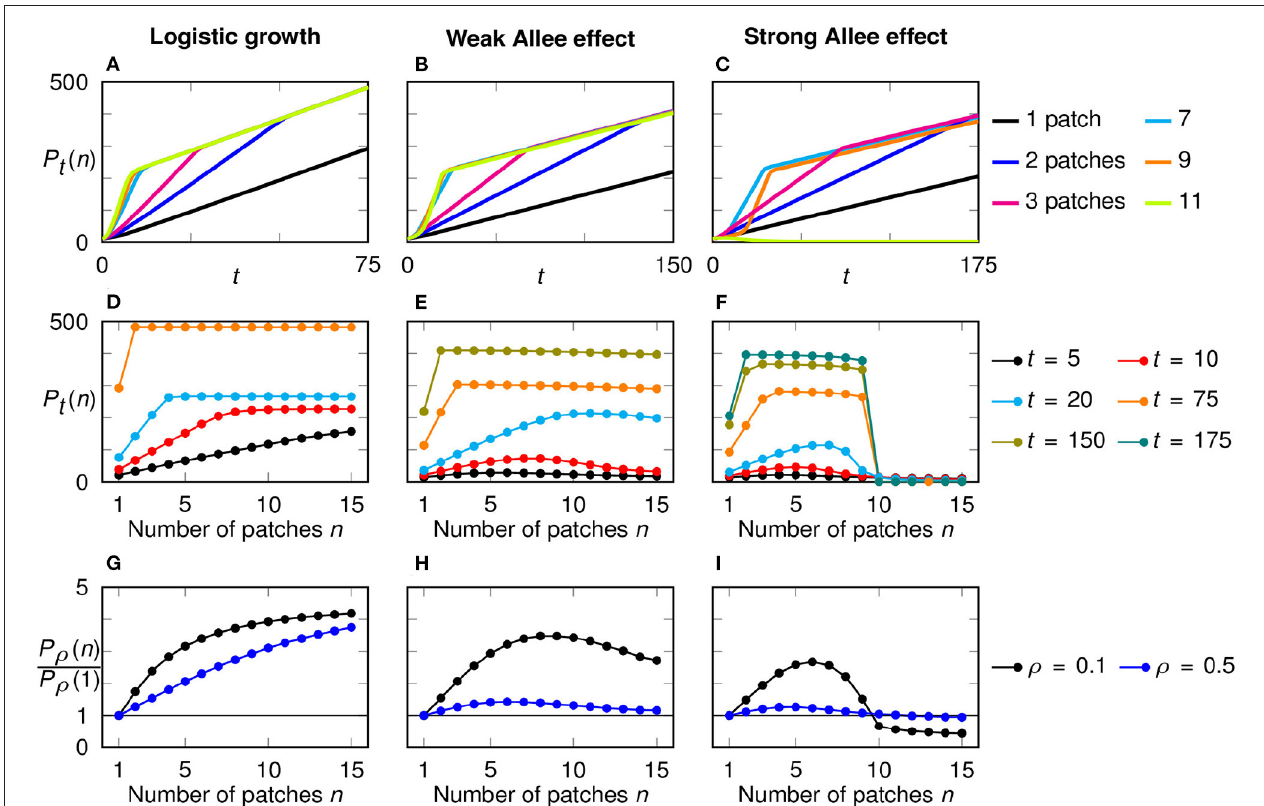
FIGURE 5 | Time dependence and growth dynamics in a configuration with multiple initial patches for logistic growth (left), weak Allee effect (middle), and strong Allee effect (right). (A–C) Temporal development of the total population size for different numbers n of initial patches, with a fixed total initial population size P 0 in the growth curves indicates the point of merging. (D–F) Total population size after a fixed time horizon in dependence of the number of initial patches. For each model, only time horizons up to the merging of the configuration with two patches are selected. (G–I) Discounted population size relative to the discounted population size for one initial patch in dependence of the number of patches, shown for two discounting